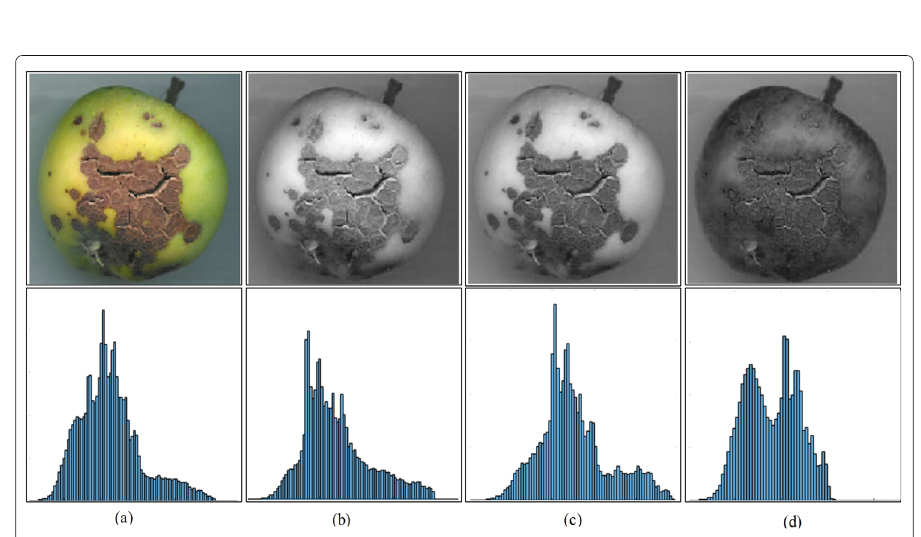
Fig. 2 Original image and red, green, and blue channels with their respective histogram. a Original image. b Red channel. c Green channel. d Bue channel